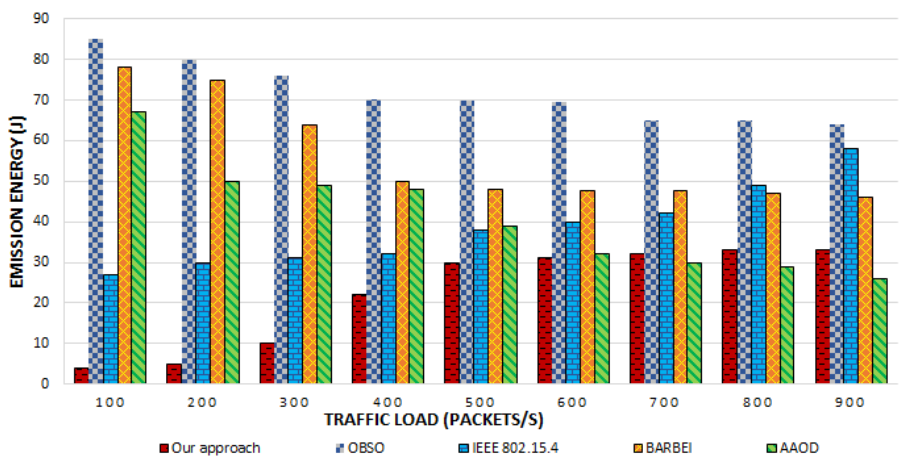
Figure 9. Emission energy consumption.